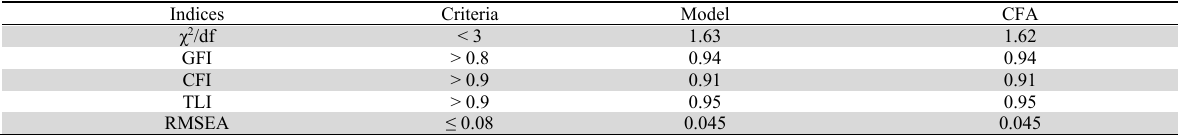
Model fit indices of measurement model